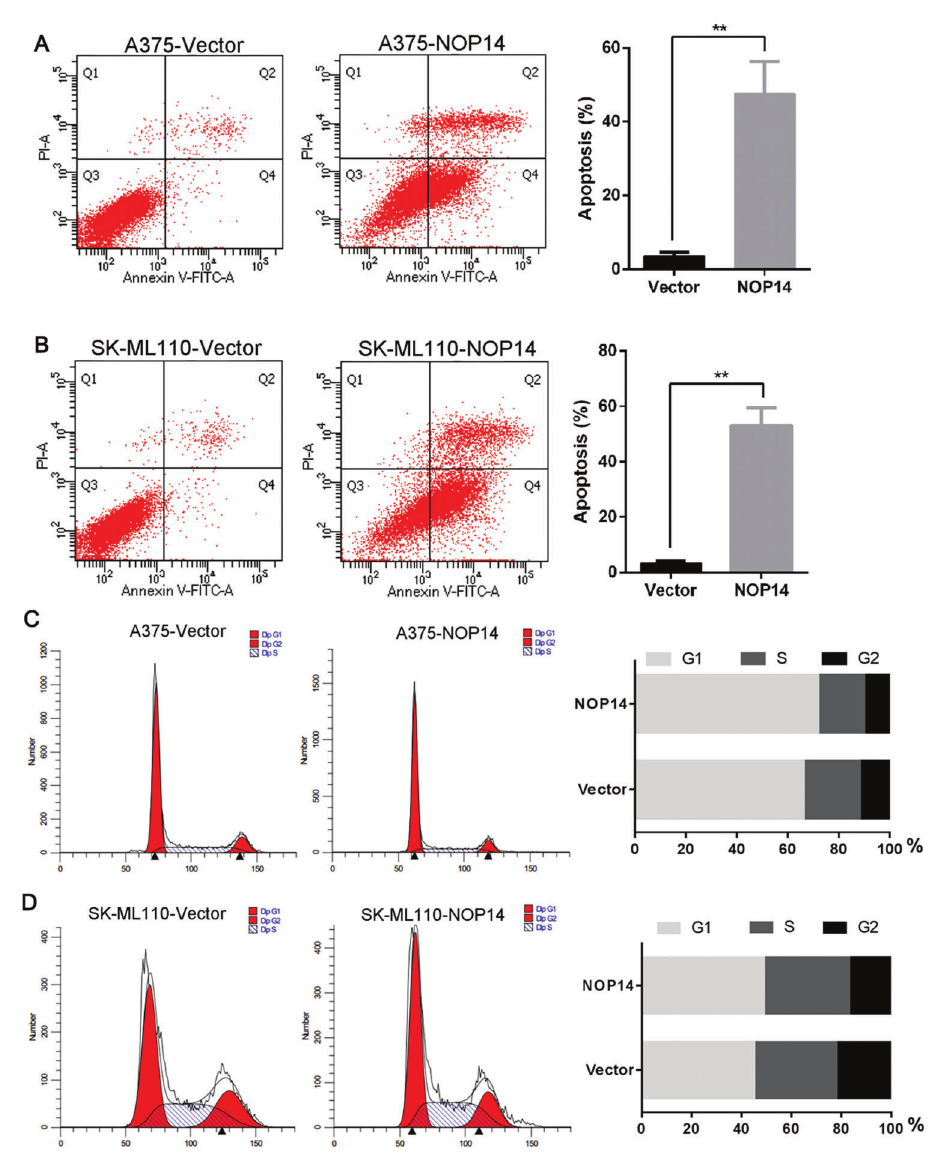
Figure 3. Apoptosis and cell cycle analysis of melanoma cells transfected with nucleolar protein 14 (NOP14) overexpression or empty vector. A and B , Apoptosis analysis of melanoma cells. C and D , Cell cycle analysis of melanoma cells. Data are reported as means ± SD. **P o 0.01 vs empty vector ( t